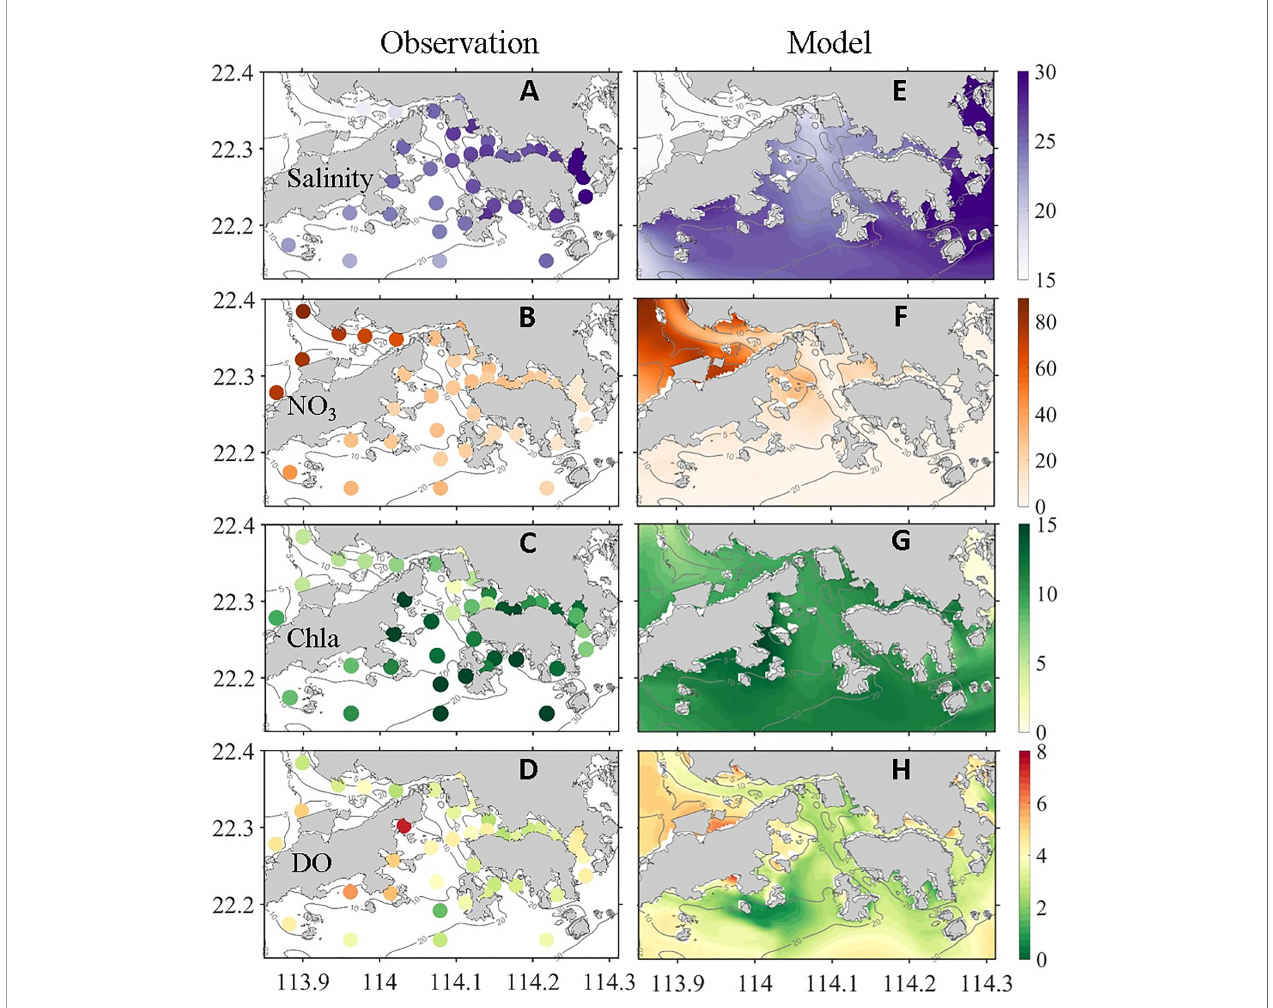
FIGURE 2 | (left column) Observed and (right column) simulated (A, E) surface salinity (PSU), (B, F) surface NO 3 ( m M L − 1 ), (C, G) surface chlorophyll ( m g L − 1 ), and (D, H) bottom DO (mg L − 1